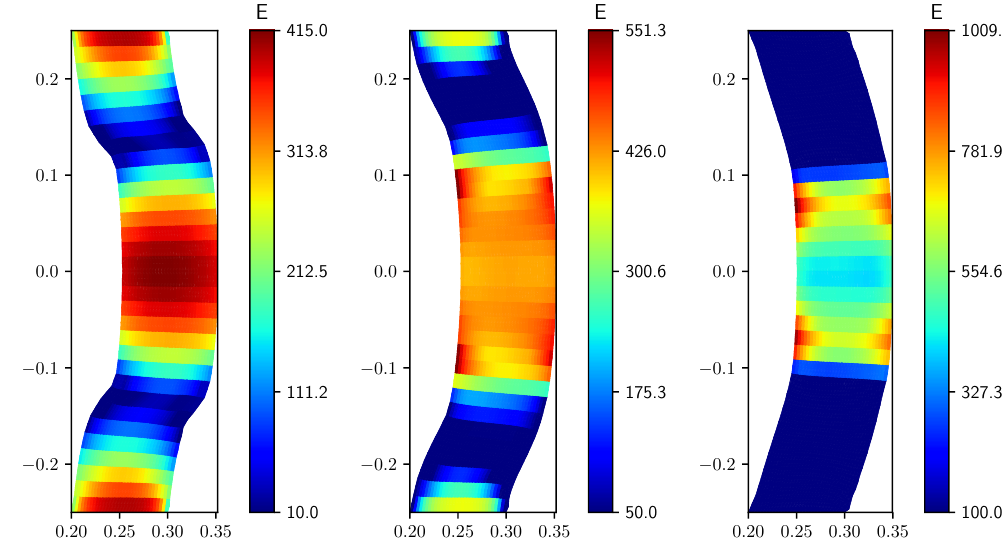
Figure 6. Young modulus E fields, discretization l = 5 with different E min = 10 Pa ( left ), 50 Pa ( center ), 100 Pa ( right ). E and E min are scaled by 2.4 Table 3. Objective functional. E min is scaled by 2.4